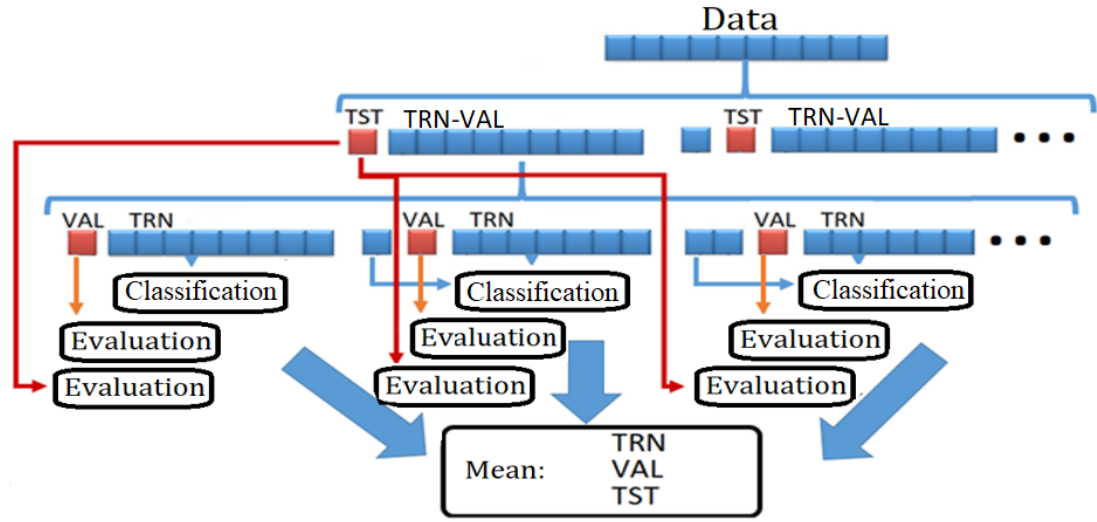
Figure 5. Methodology for cross-validation. The original dataset is split several times to have partitions of data into subsets for model training and evaluation.